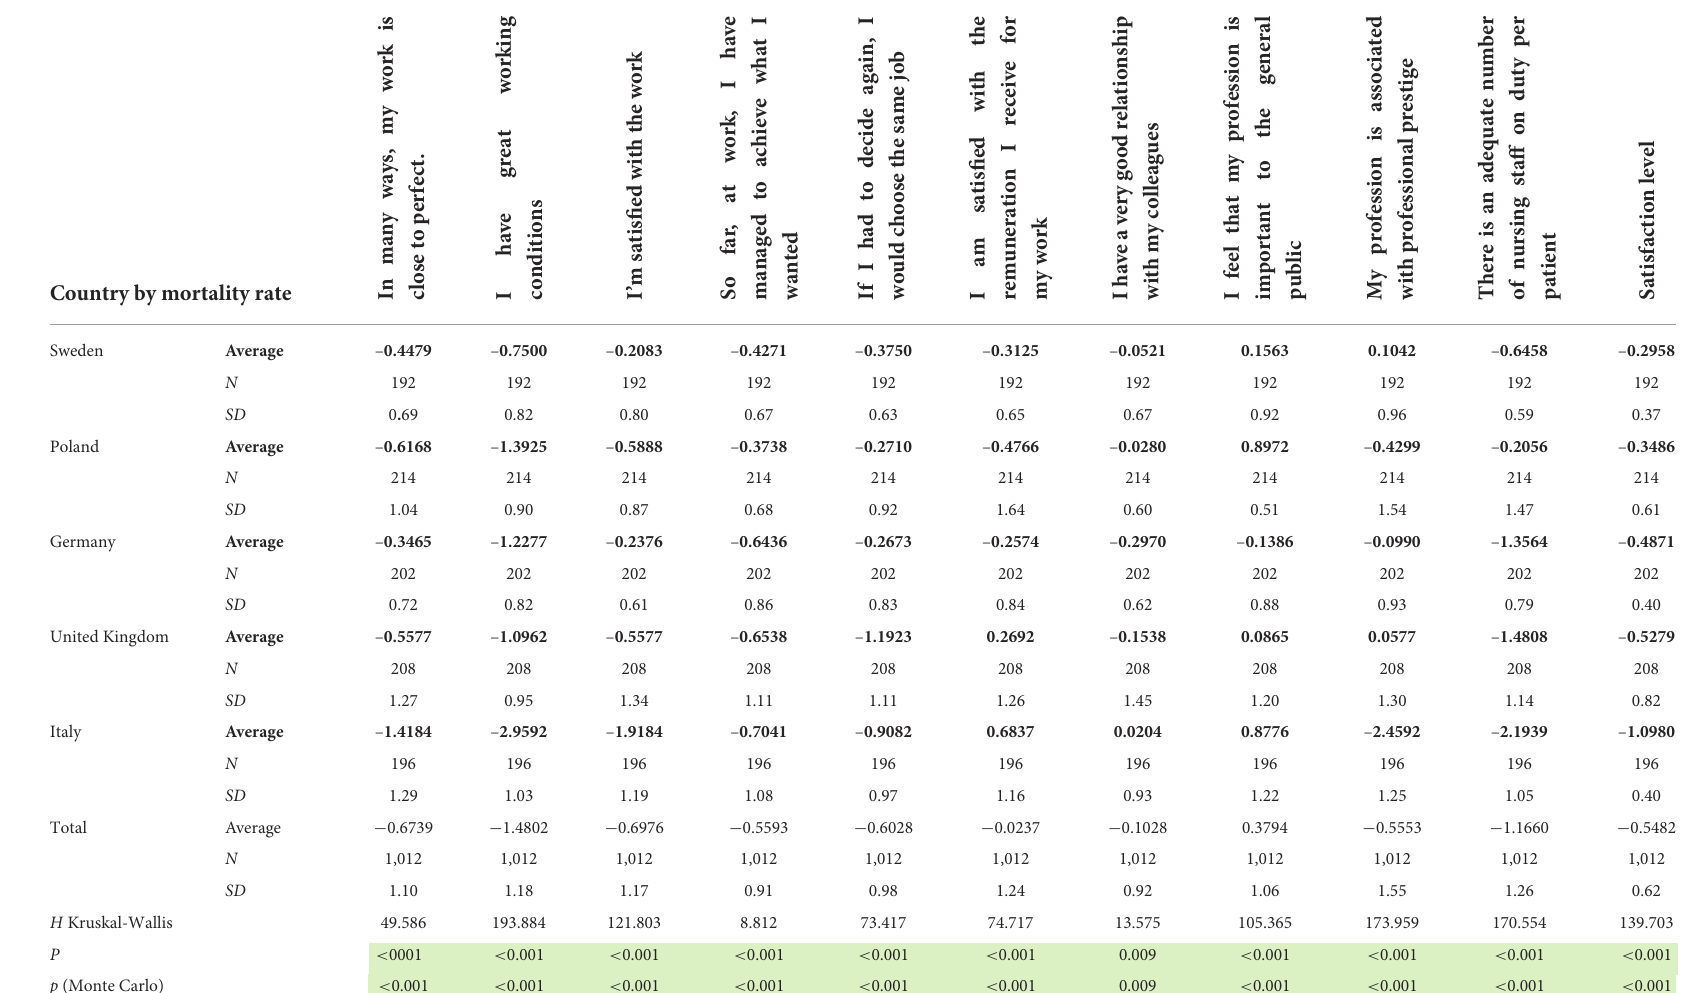
TABLE 4 The impact of the COVID-19 pandemic on job satisfaction of nursing staff in individual